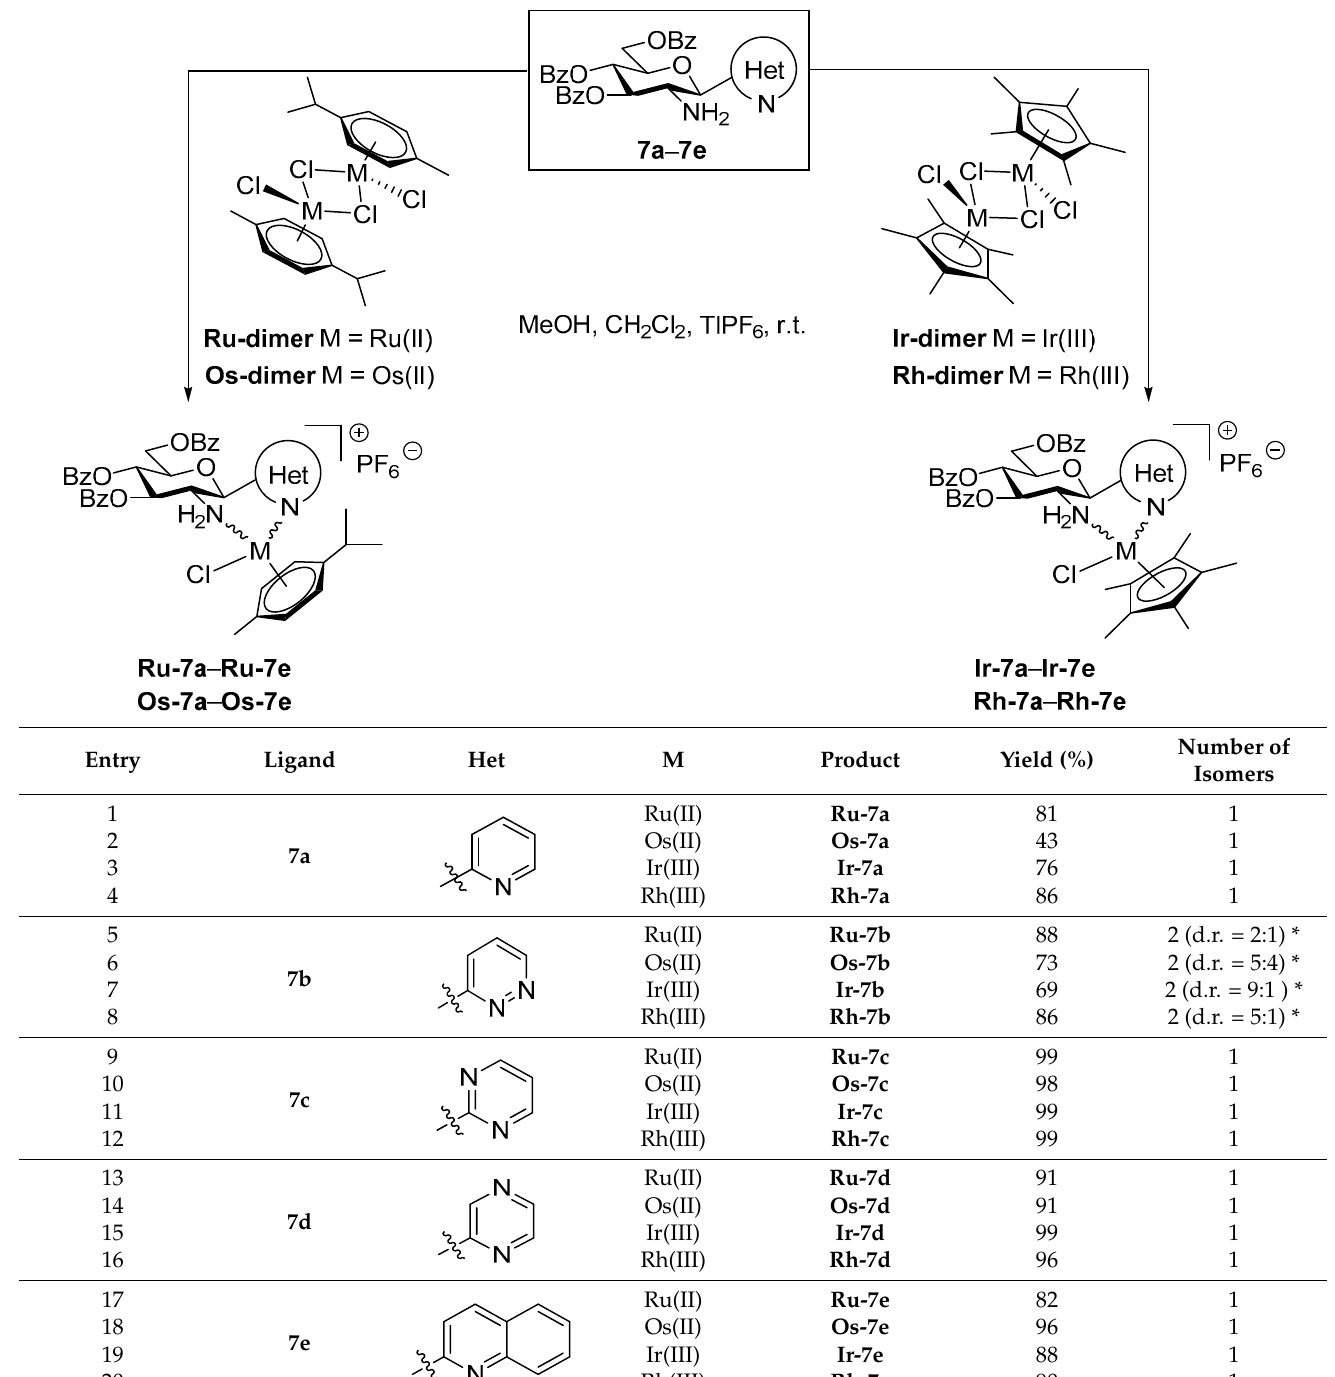
Table 5. Synthesis of half-sandwich platinum-group metal complexes with the O -perbenzoylated C -glucosaminyl azines.